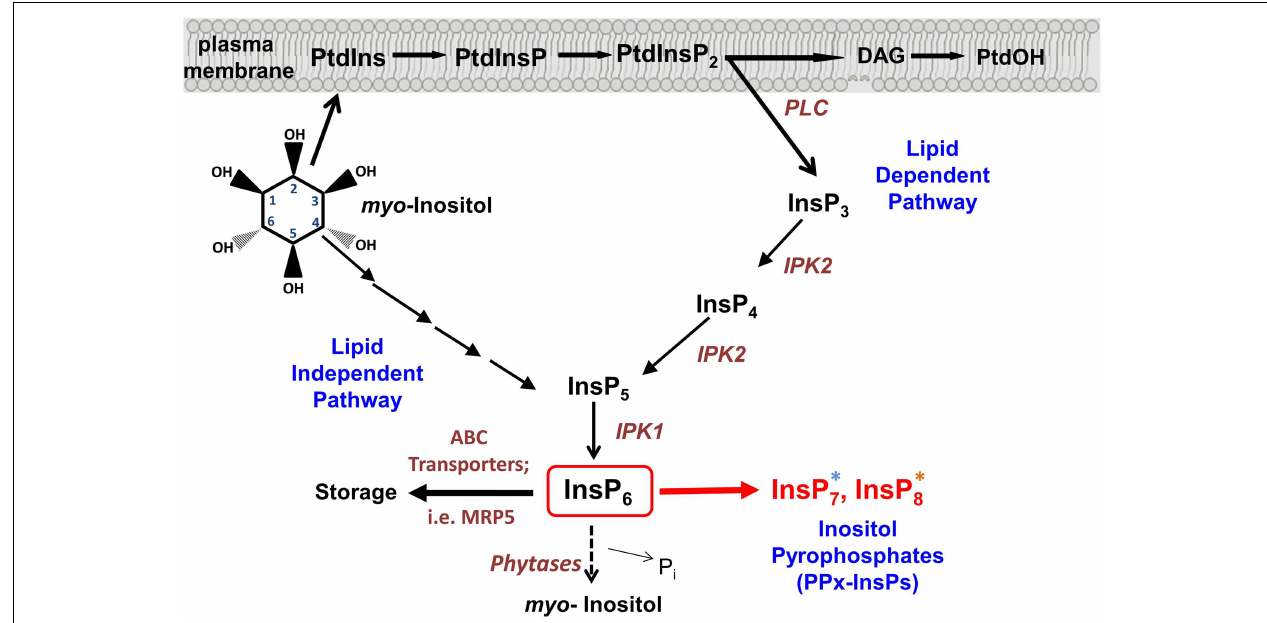
FIGURE 1 | Synthesis of inositol pyrophosphate. Overview of the Inositol phosphate pathway, including both lipid dependent and lipid independent routes for synthesis of InsP 6 . Inositol Pyrophosphate (PPx-InsP) synthesis is indicated in red. Major lipid and inositol